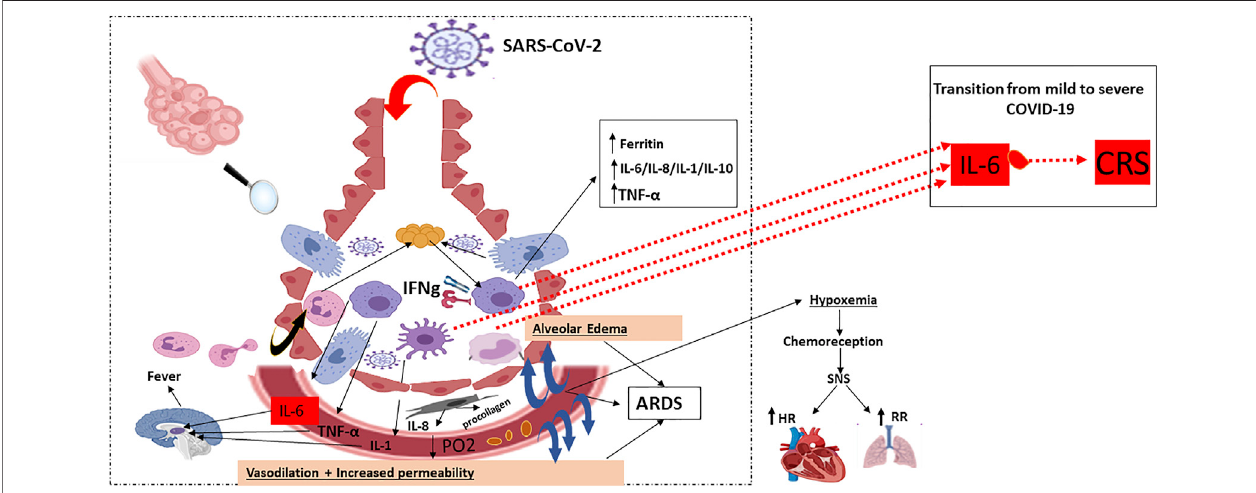
FIGURE 2 | Host immune response: pulmonary recruitment of macrophages and dendritic cells in response to chemokine and cytokine release: Characterised by DAMP/PAMPs recognition, pro-in fl ammatory cytokine and chemokine release (early phase), activation of different cells of the mononuclear phagocyte system and virus speci fi c cytotoxic T cells recruitment (late phase). Activated macrophages, monocytes and dendritic cells secrete IL-6 in increased quantities: IFN- γ : Interferon- γ ; TNF- α : Tumornecrosisfactor- α ; ARDS: AcuteRespiratory Distress Syndrome; PO2 : Partial Pressure ofOxygen; SNS : Somatic Nervous System; HR : Heart Rate; RR : Respiratory Rate; IL : Interleukin; CRS : Cytokine Release